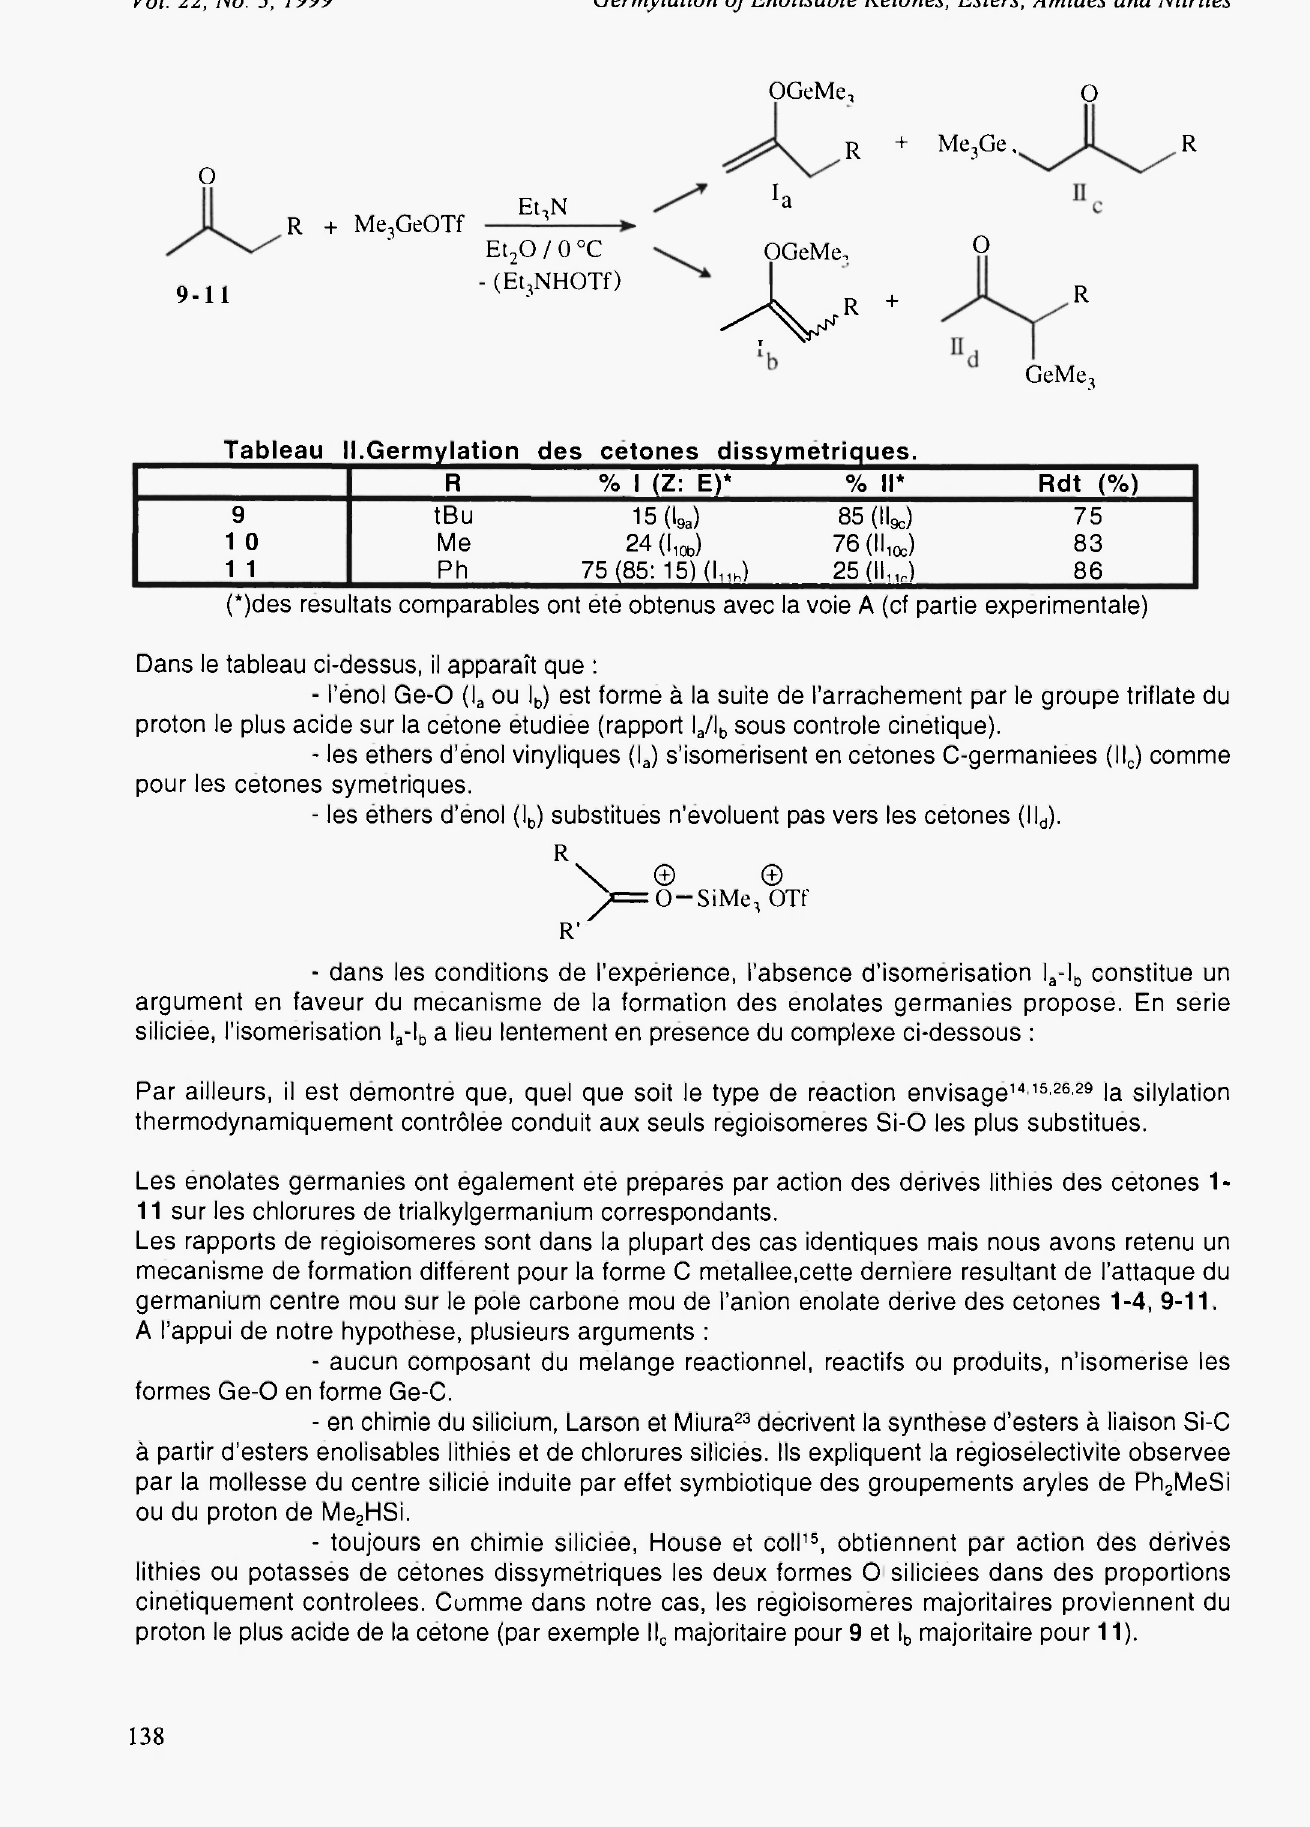
II.Germylation des cetones dissymetriques. R % I (Ζ: